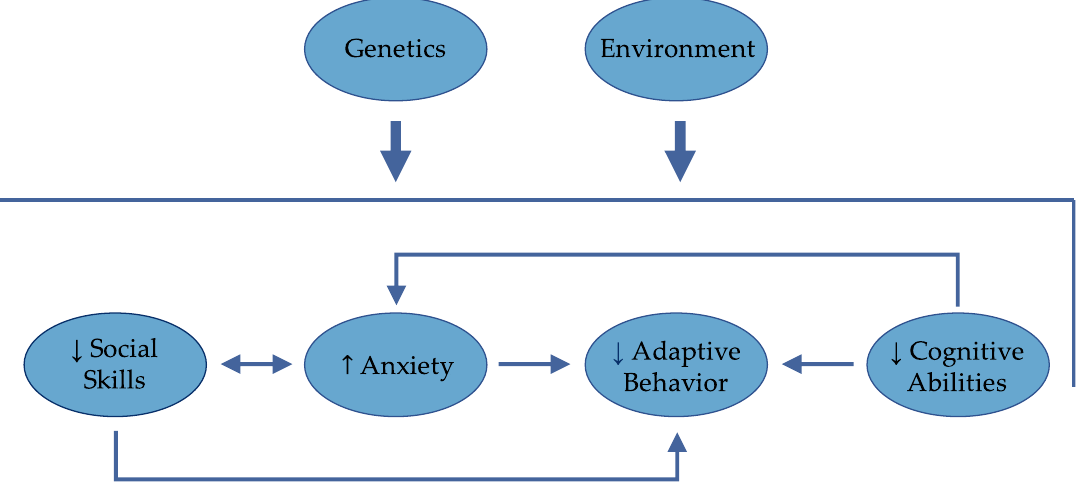
Figure 5. Genes, environment, cognitive, and socio-emotional factors all intersect to determine outcome. Anxiety may be inversely related to social skills, adaptive behavior, and cognitive abilities.